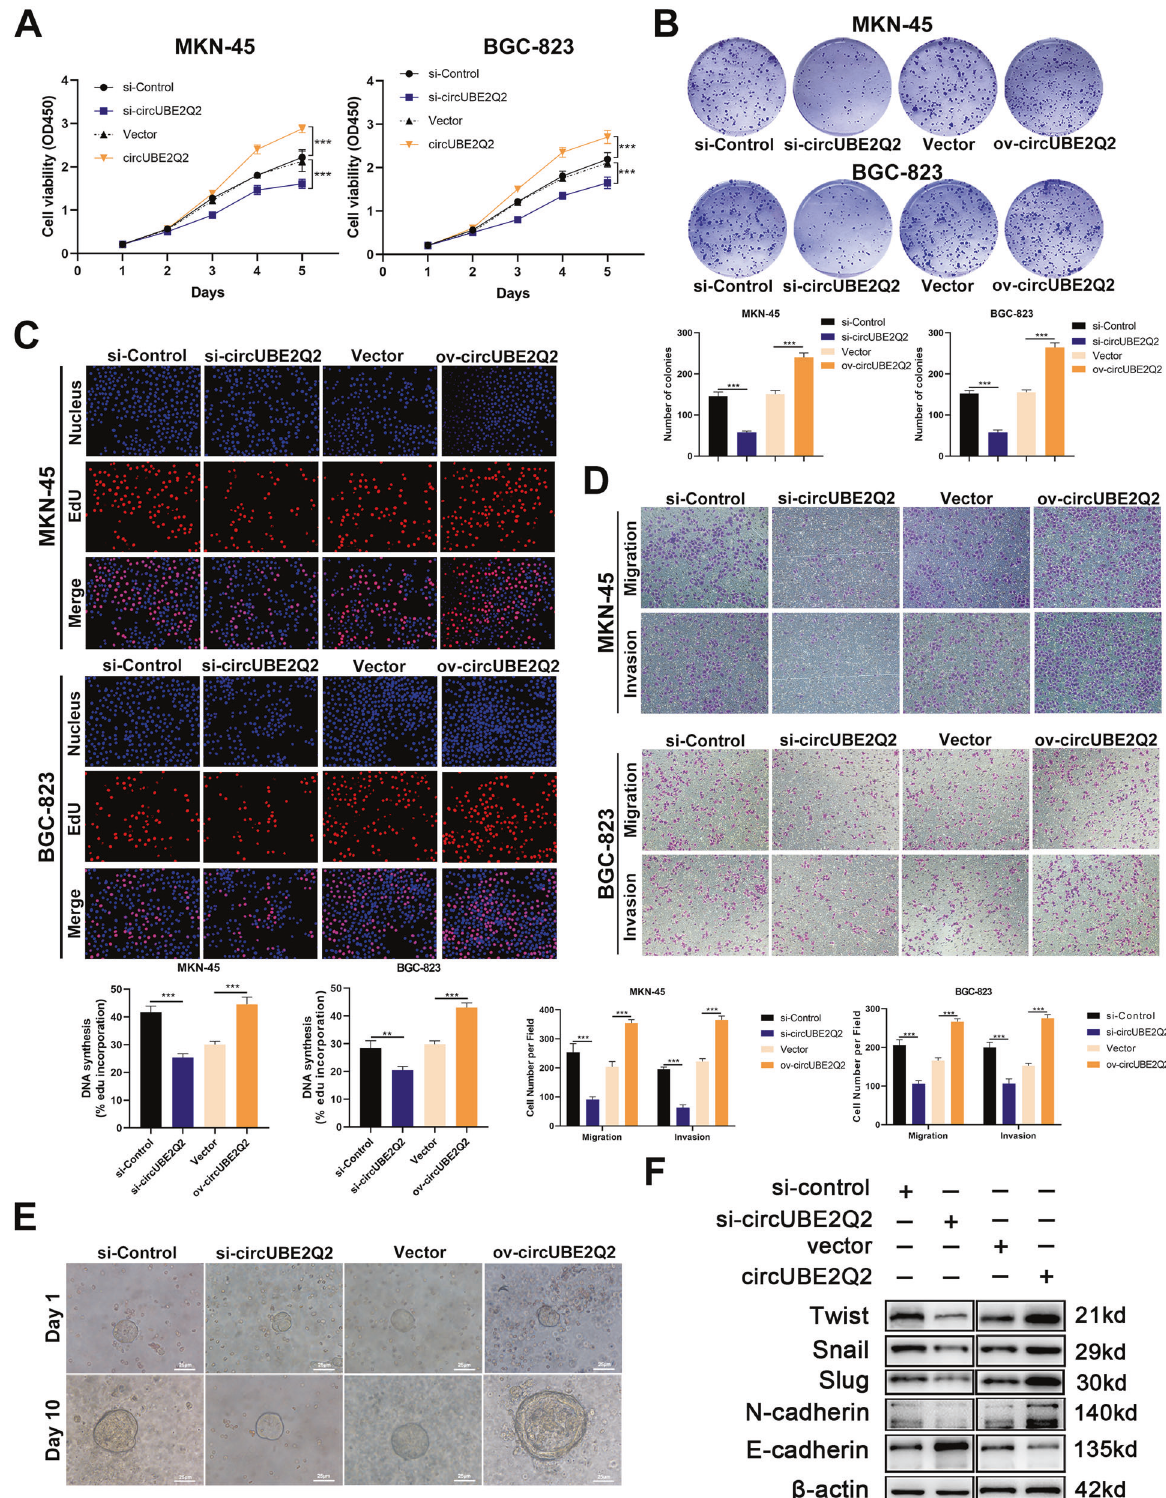
Fig. 2 CircUBE2Q2 promotes the proliferation, migration, and invasion of GC cells in vitro. A Assessment of the proliferation of MKN-45 and BGC-823 cell lines transfected with circUBE2Q2-speci fi c siRNA or an overexpression plasmid by CCK-8 assay. B Assessment of cell proliferation by colony formation assay. C Assessment of cell proliferation by EDU assay. D Assessment of migration and invasion of by transwell assay. E Gastric cancer organoid models indicating the effect of circUBE2Q2 on the growth of GC, scale bar = 25 µm. F The protein level of EMT-related genes (TWIST, Snail, Slug, N-cadherin, and E-cadherin) in GC organoid models detected by western blotting. Data are expressed as the mean ± SD. * p < 0.05, ** p < 0.01, *** p < 0.001.